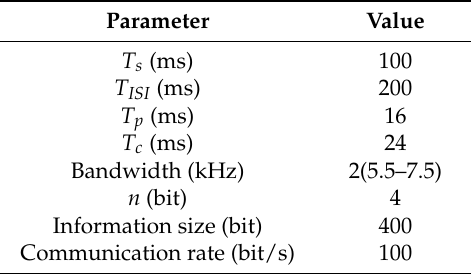
Table 1. Parameters of the communication